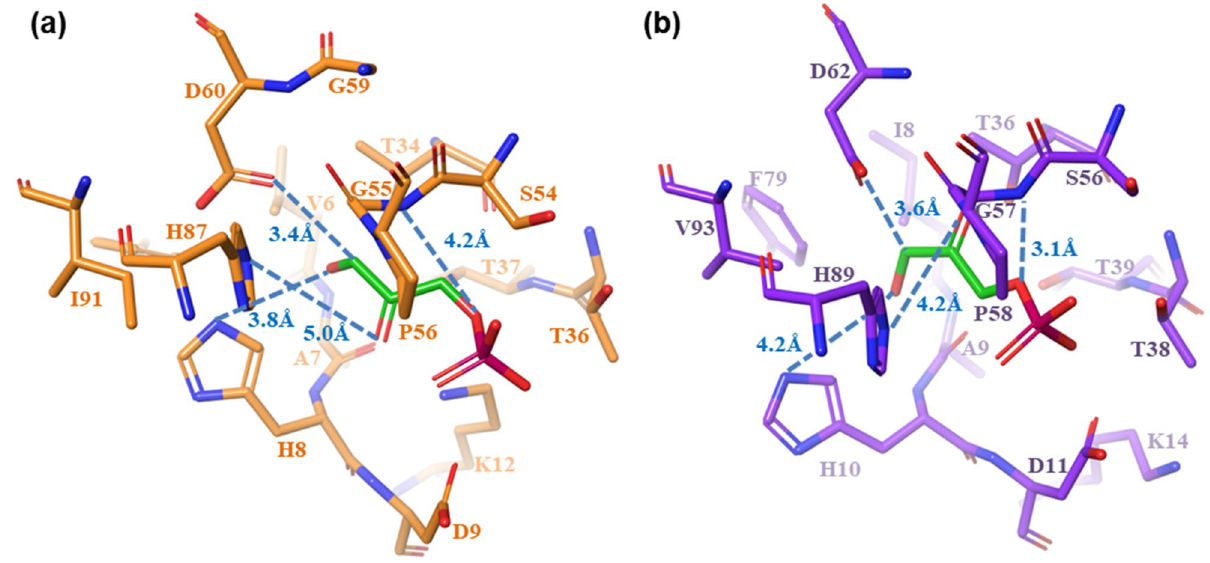
Figure 5. DHAP-docked enzymatic active sites. ( a ) cdMGS; ( b ) opMGS. The carbon atoms of DHAP, cdMGS and opMGS are colored as green, orange and purple, respectively. Nitrogen, oxygen, and phosphorous atoms are colored as blue, red and magenta, respectively. Distances between the key residues and substrate atoms are marked by dashed lines. ΔG bind for DHAP in cdMGS and opMGS were − 3.76 and = − 3.01 kcal mol −1 , respectively.